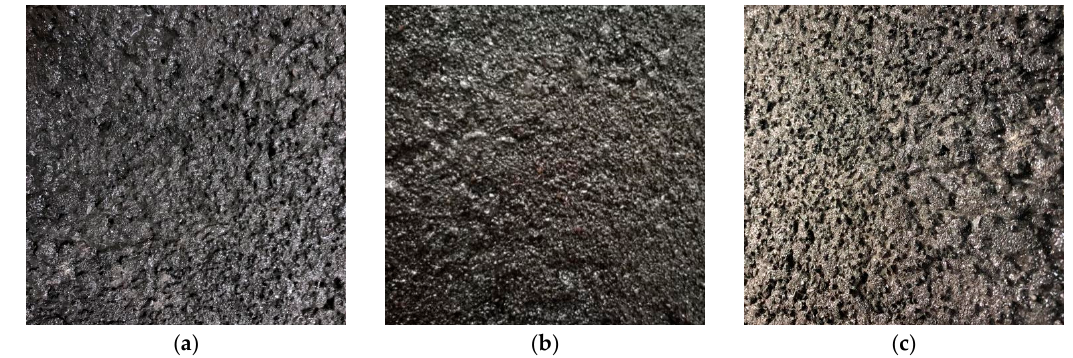
Figure 21. Construction technology: ( a ) one oil and one sand; ( b ) two oils and one sand; ( c ) premix. Coatings 2020 , 10 , x FOR PEER REVIEW